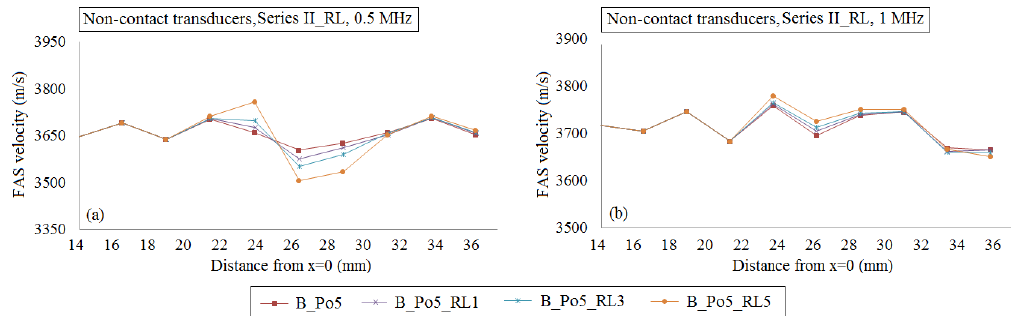
Figure 11. The potential of the local FAS velocity to detect the occurrence of a single RL considering cortical bone as a homogeneous medium (geometries illustrated in Figure 3a–e). The diagrams correspond to the second set of simulations when the transducers are placed at a distance of 2 mm from the cortical cortex. The results for the excitation frequencies : ( a )–( c ) 0.5 MHz; and ( d )–( f ) 1 MHz are presented. The legend describes the center coordinates of the RL.